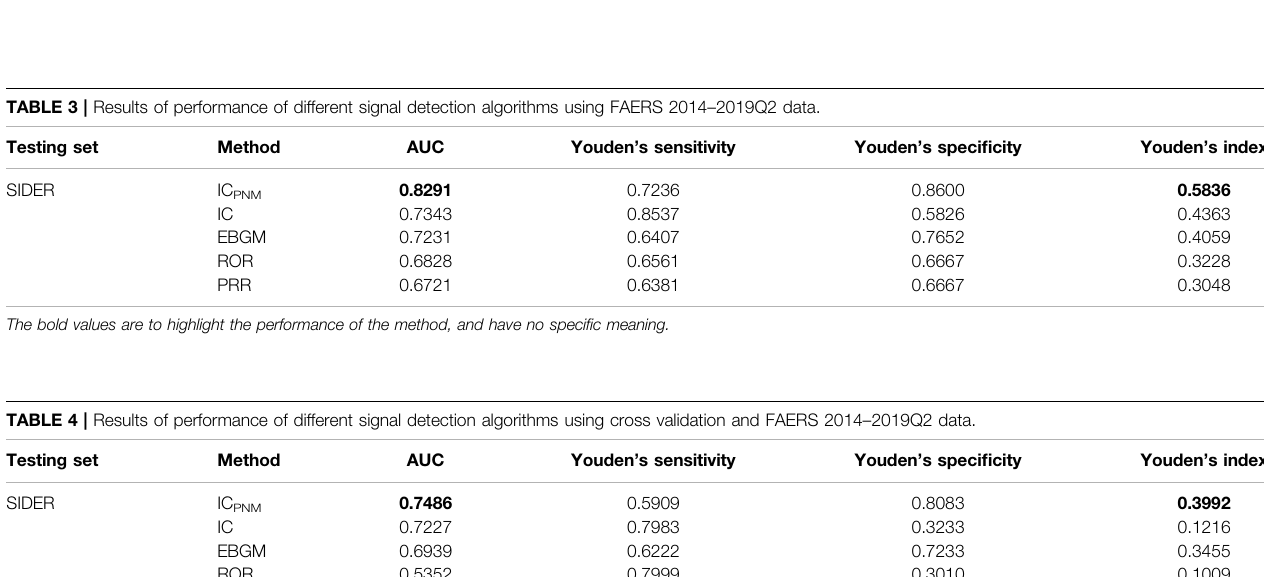
Frontiers in Pharmacology |